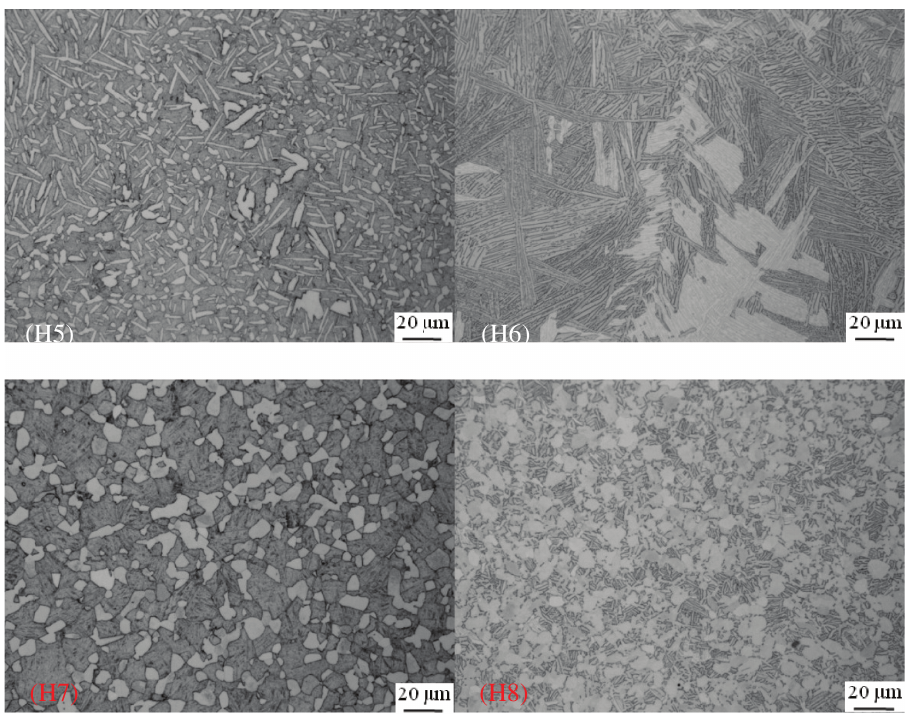
Figure 4: The microstructure of Ti6Al4V rolling bar at rolling temperature 1010 ℃ (H5&H6), 930 ℃ (H7&H8) after heat treatment at 950 ℃ for 1.5 h followed by WC then age at 540 ℃ for 6 h followed by AC (H5&H7), 800 ℃ for 1.5 h followed by AC (H6&H8).